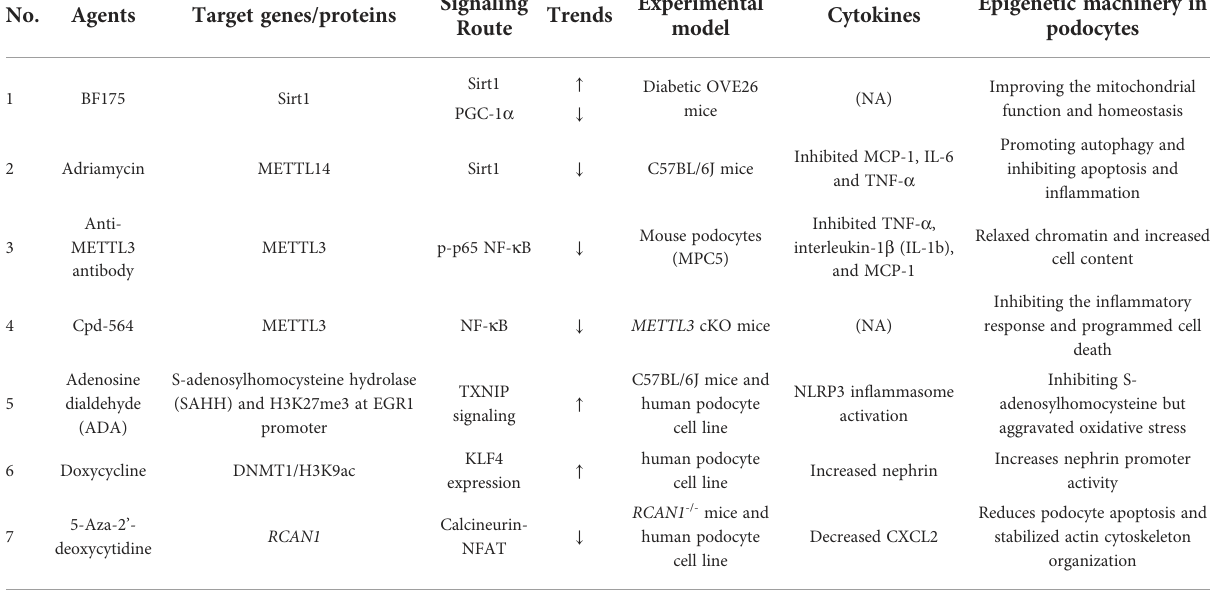
TABLE 1 Reports of epigenetic drug treatment on podocytes during DN